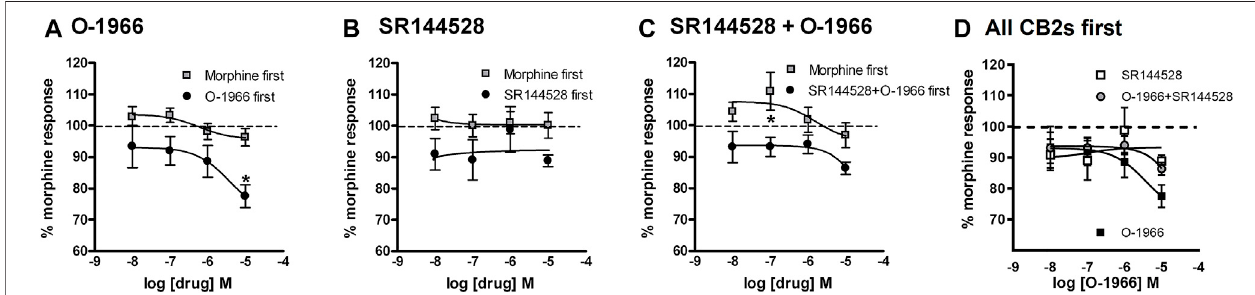
FIGURE 7 | Effect of increasing doses of O-1966 and SR144528 on morphine-stimulated GTP γ S binding. O-1966 given before, but not after, morphine inhibits morphineresponsein[ 35 S]GTP γ Sbindingassays.Atthehighestdose(10 µM)O-1966,thereisa20%reductioninthemorphineresponsefrombaseline.Opensquares indicate 10 min pretreatment with 0.5 µM morphine and closed squares indicate 10 min pretreatment with varying concentrations of either O-1966 (A) , SR144528 (B) , oracombinationofSR144528withO-1966 (C) (10 nM – 10 µM).Whenthecannabinoidcompoundsareadministered fi rst,theco-administrationofSR144528and O-1966indicatesthattheinhibitoryeffectofO-1966canbeblockedbySR144528 (D) .Eachdatapointrepresentsthemean(±S.E.M.)ofthreeindependentexperiments run in duplicate (*) indicates a statistically signi fi cant ( p < 0.05) difference from baseline morphine response.